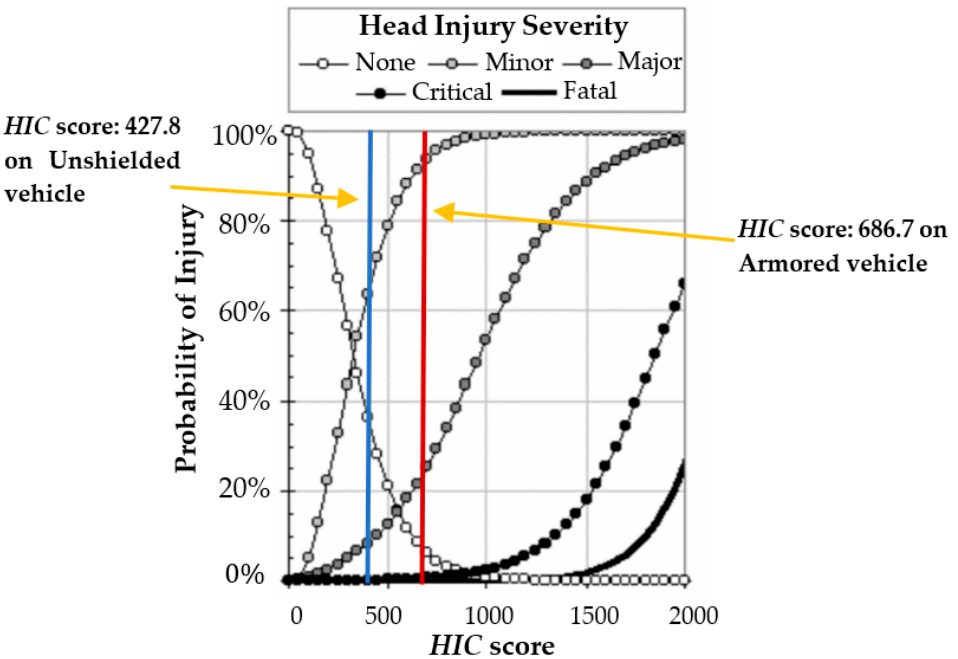
Figure 17. Head injury severity “Expanded Prasad-Mertz Curves”.